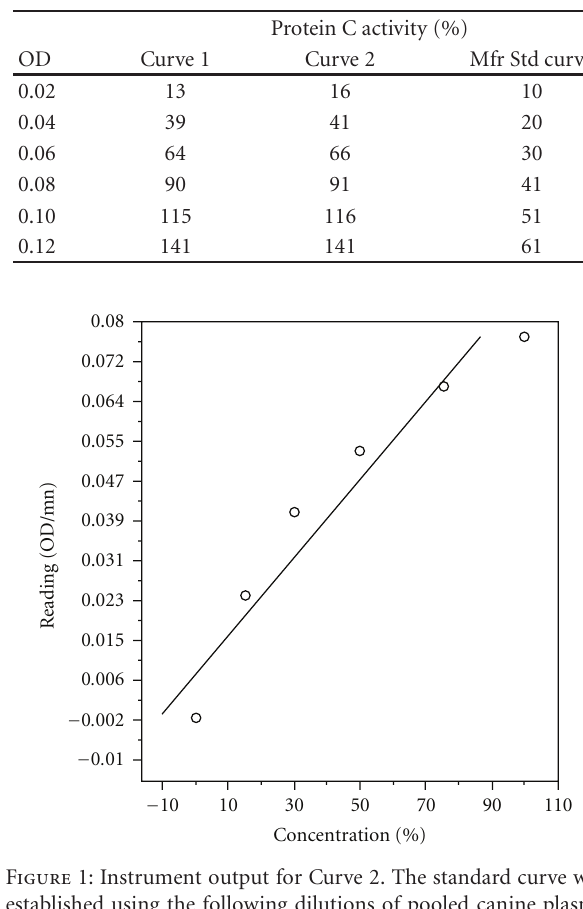
Table 1: Plasma storage conditions for Phase 1 (a) and Phase 2 (b). Table 2: Comparison of standard curves generated 1 week apart, using pooled canine plasma(Curves 1 and 2), and a curve generated (a) using the manufacturer’s standard protocol (Mfr Std). Results for protein C (PC) activity shown here are hypothetical, calculated by inserting arbitrary optical density (OD) values into the regression equations for the curves (Curve 1: c = [1278.276 × d] − 12.397; Curve 2: c = [1257.324 × d] − 9.60; Mfr Std curve: c = [515.734 × d] − 0.608; where c = PC activity and d = OD). Actual instrument output for Curve 2 is shown in Figure 1.